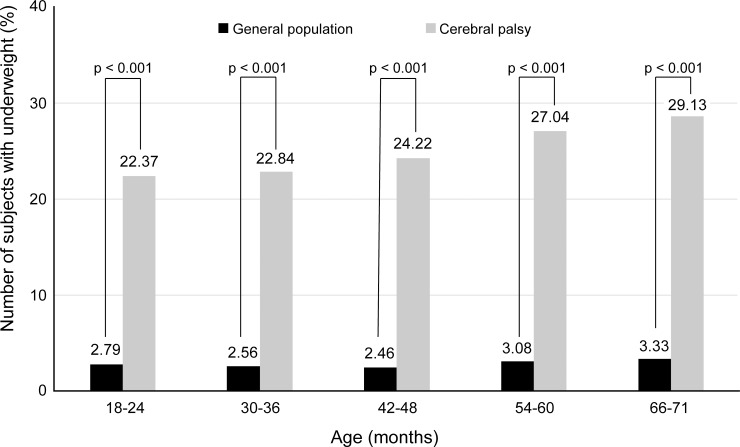
Comparison of underweight.Comparisons were made between the subjects in the general population and subjects with cerebral palsy at each National Health Screening Program for Infants and Children screening after the age of 1 year. The number on each bar is the mean value of the percentage of subjects who are underweight.